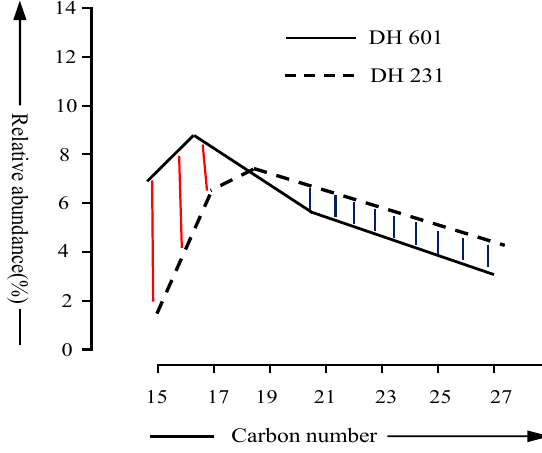
Figure 12. Comparison of distribution curve of C 15 + n ‐ alkanes .